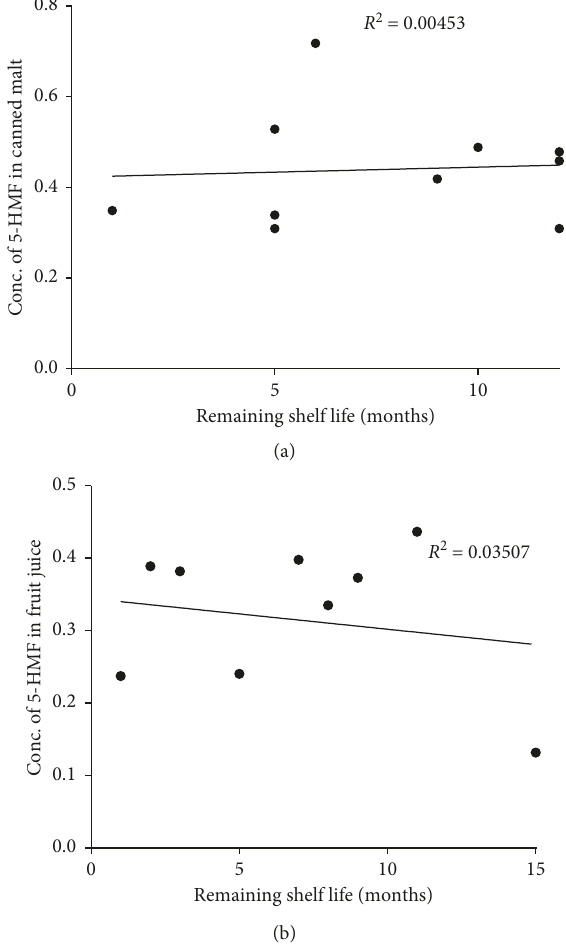
Figure 7: Relationship between remaining shelf life of products sampled and 5-HMF levels. Results show poor correlations between concentrations of 5-HMF and remaining shelf life. In effect, the months left of the products’ shelf life do not necessarily contribute to 5-HMF levels in the sampled